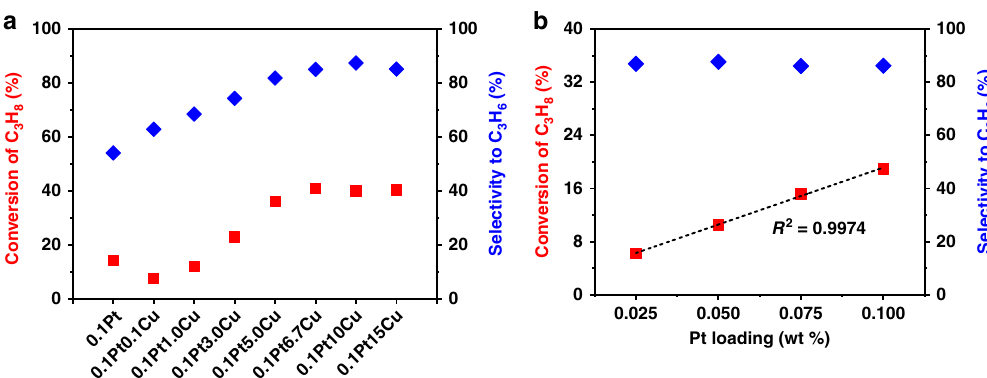
Fig. 2 Initial activity as a function of Pt/Cu atom ratio. a The initial activities of the catalysts with fi xed amount of Pt (0.1 wt%) and increasing content of Cu (0, 0.1, 0.3, 3, 5, 6.7, 10, and 15 wt%). With the Cu/Pt atom ratio increasing, the initial conversion of propane fi rst rises and then remains unchanged, implying a critical Cu/Pt molar ratio for the formation of Pt/Cu SAA. b The initial activities of the catalysts with fi xed amount of Cu (10 wt%) and progressively decreasing content of Pt (0.1, 0.075, 0.05, and 0.025 wt%). The excellent linear correlation between the initial activity and Pt concentration supports the formation of Pt/Cu SAA. Catalytic conditions: atmospheric pressure, 600 °C, C 3 H 8 /H 2 = 1/1, with balance N 2 for total fl ow rate of 50 mL min − 1 , WHSV of propane = 4 h − 1 and 250mg of sample ( a ) or WHSV of propane = 40 h − 1 and 25 mg of sample ( b